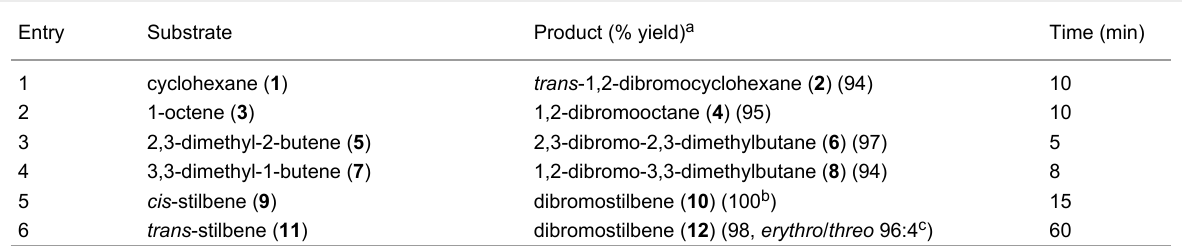
Table 1: Addition reactions of bromine under solvent-free PV-PTFE conditions.